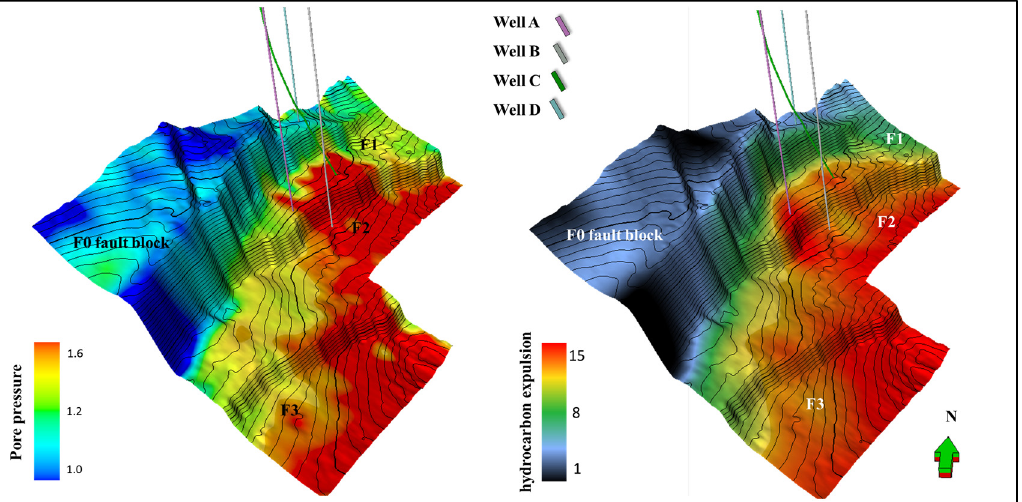
Figure 13. Pore pressure coefficient at P12 in the Pinghu field and Hydrocarbon-generating intensity at P12 in the Pinghu block. High pore pressure was developed in the range of high hydrocarbon expulsion.